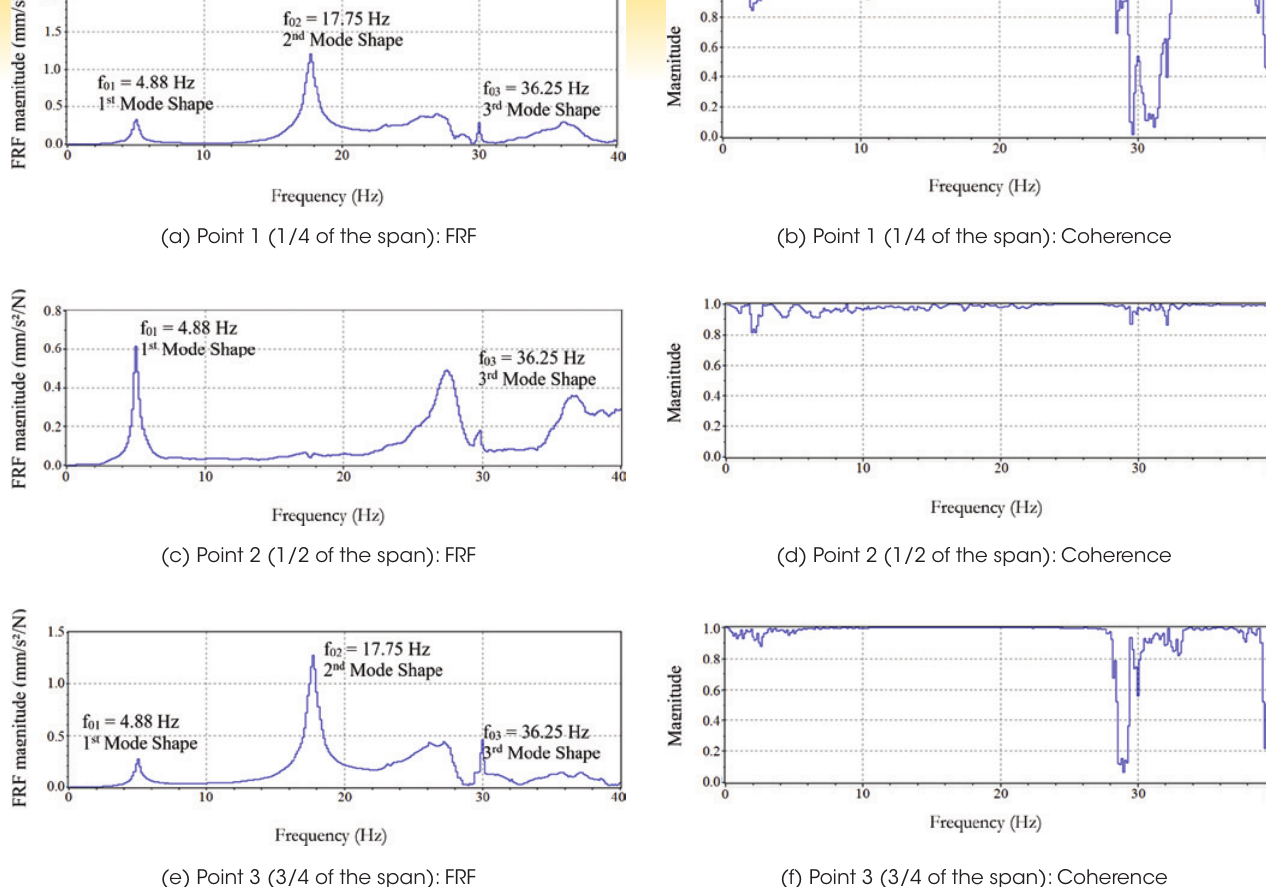
(f) Point 3 (3/4 of the span): Coherence